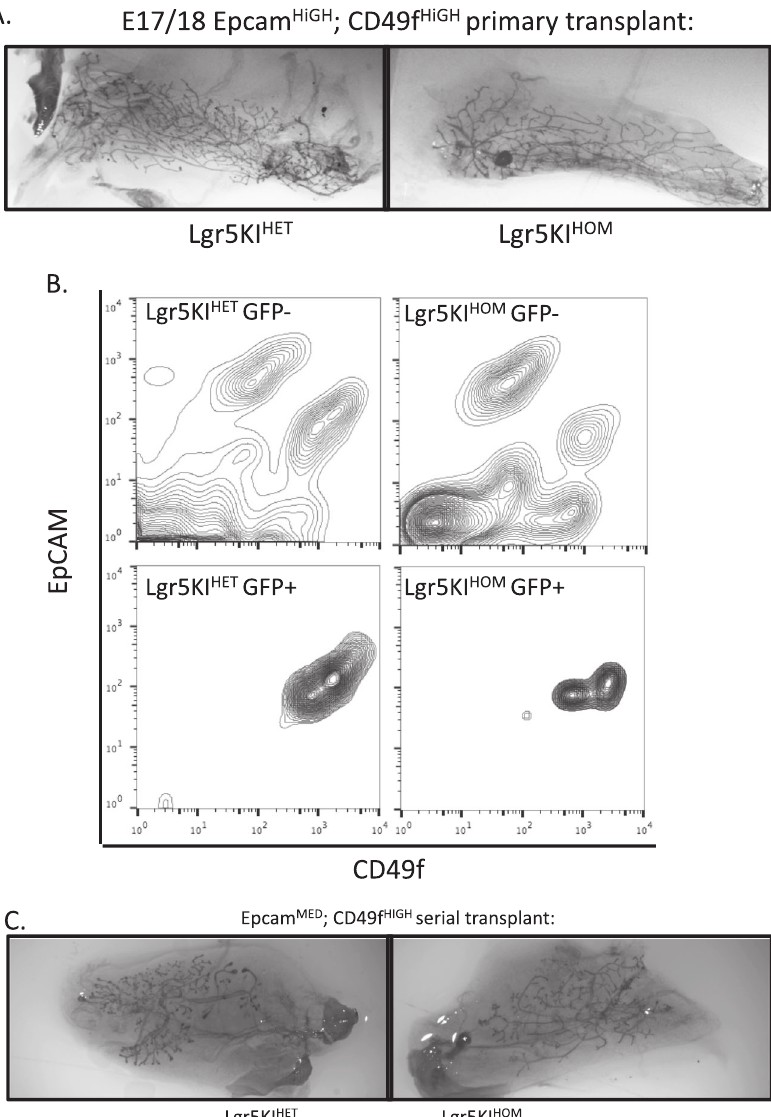
Fig. 5 Lgr5 function is not required for mammary transplantation capacity. a Single-cell suspensions were prepared from Lgr5KI HET and Lgr5KI HOM littermates at stage E18. Live, single, EpCAM HIGH ; CD49f HIGH ; GFP POS cells were sorted and injected into cleared fat pads of recipient mice. Eight weeks later, glands were isolated and carmine stained to visualize outgrowth and take rates were calculated as the fraction of positive outgrowths per number of injections. b Three thousand fMaSCs from Lgr5KI HET and Lgr5KI HOM littermates were transplanted into four fat pads each and outgrowths were produced as described in a . Outgrowths were dissociated and single cells were pooled and measured for GFP, EpCAM, and CD49f expression using FACS. c Four thousand cells from the EpCAM MED ; CD49f HIGH population described in Fig. 4b were re- transplanted into two recipient, cleared fat pads for each genotype. Eight weeks later, secondary transplants were carmine stained to visualize epithelium of secondary outgrowths. Images are representatives of three positive outgrowths for each